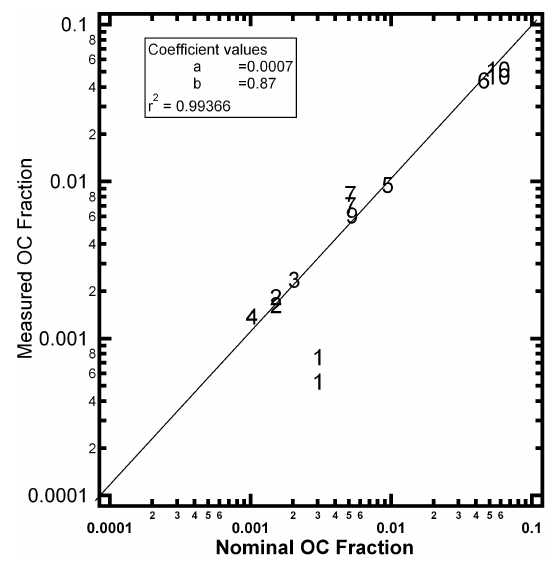
Fig. 7. The SRM samples that are listed in Table 1 were analyzed using the thermal/optical analysis (examples shown in Figs. 5 and 6) to derive the weight percent of OC for comparison with the nomi- nal values. This graph shows the comparison where the numbers refer to the samples in Table 1. The coefficient values refer to the linear regression, Y = a + bX , where X and Y are the nominal and measured values, respectively. The correlation coefficient is given by r 2